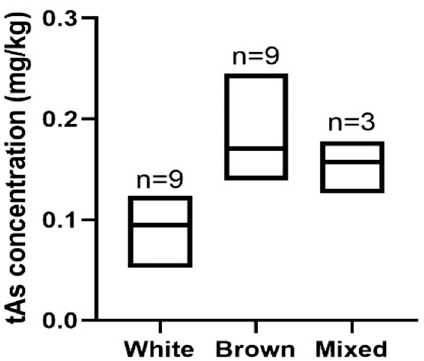
Figure 3. Box plot with line at mean for total arsenic (tAs) concentrations for rice crackers made from white, brown and both white and brown rice (mixed).